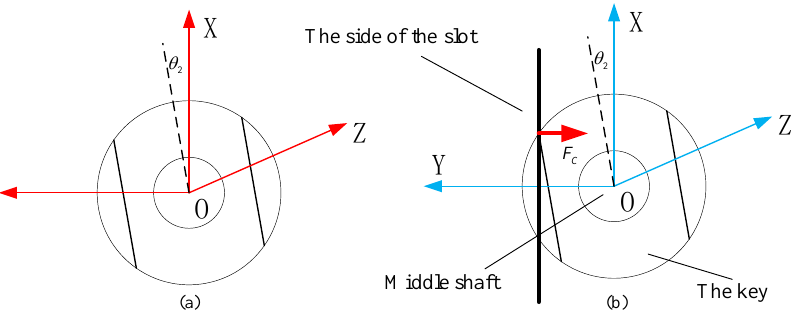
Figure 6. The rotation angle of the key part. ( a ) The angle error of the key posture; ( b ) error compensation with contact force.